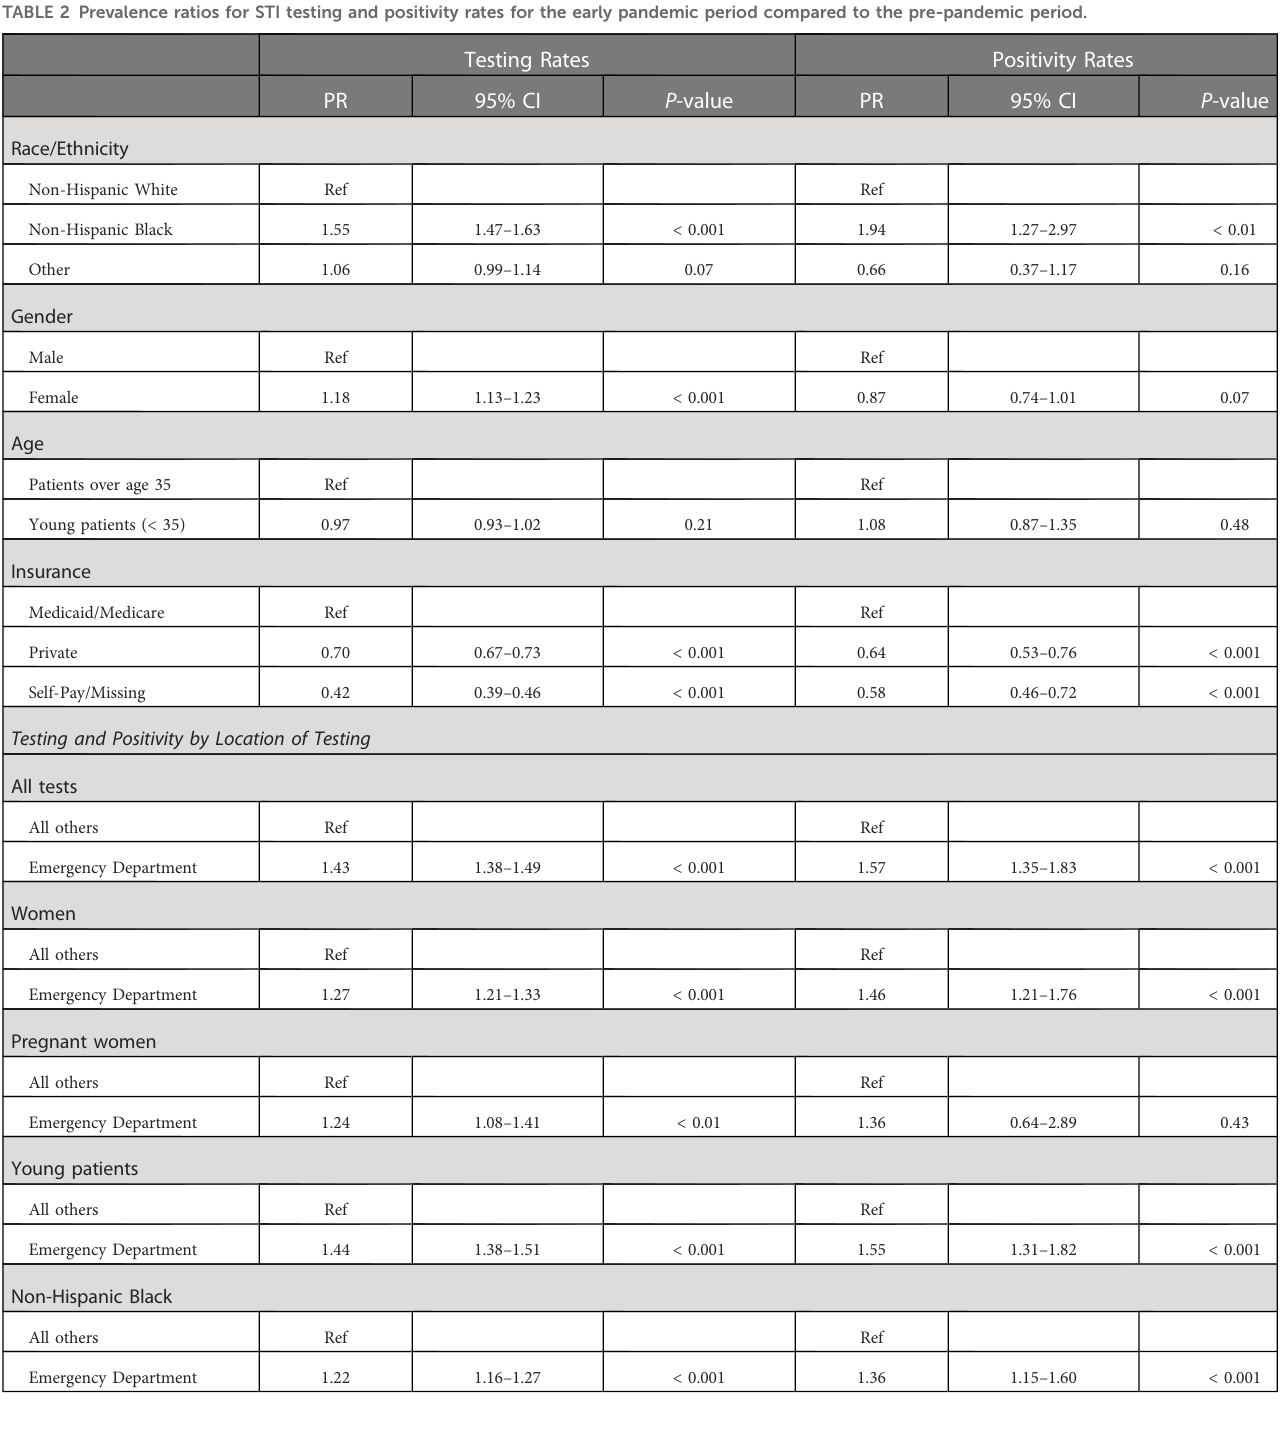
TABLE 2 Prevalence ratios for STI testing and positivity rates for the early pandemic period compared to the pre-pandemic